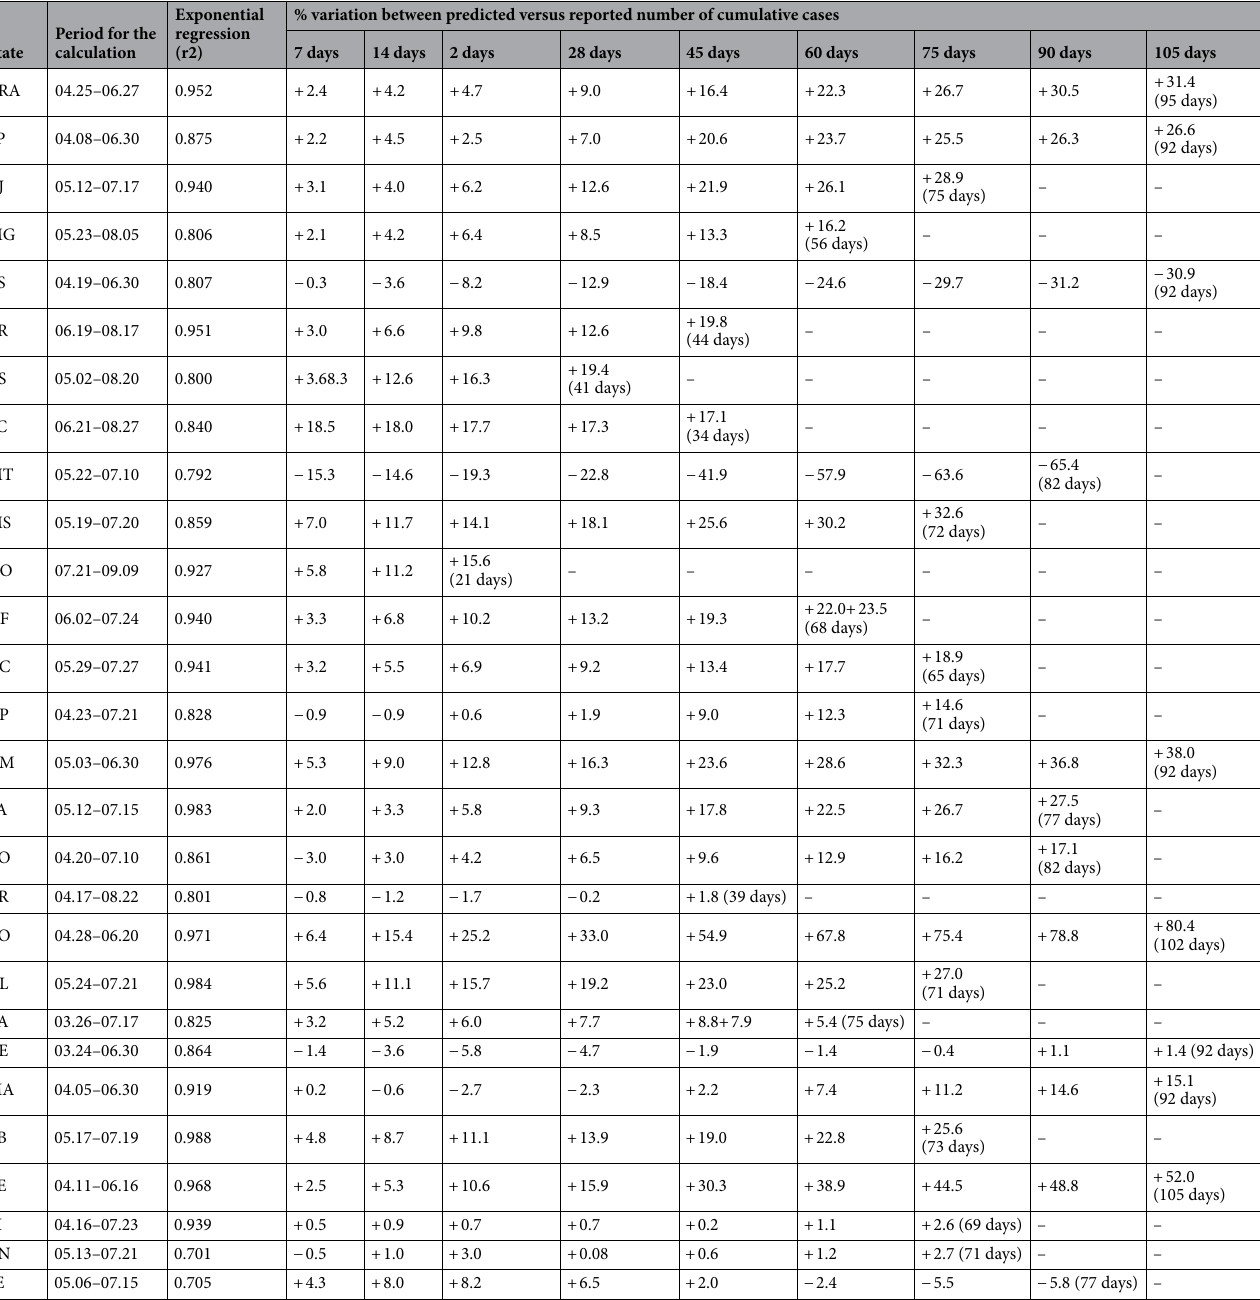
Table 1. Predictions for the whole Brazil and its states using the growth rate model for new cases. Numbers in parentheses indicate the last day of the